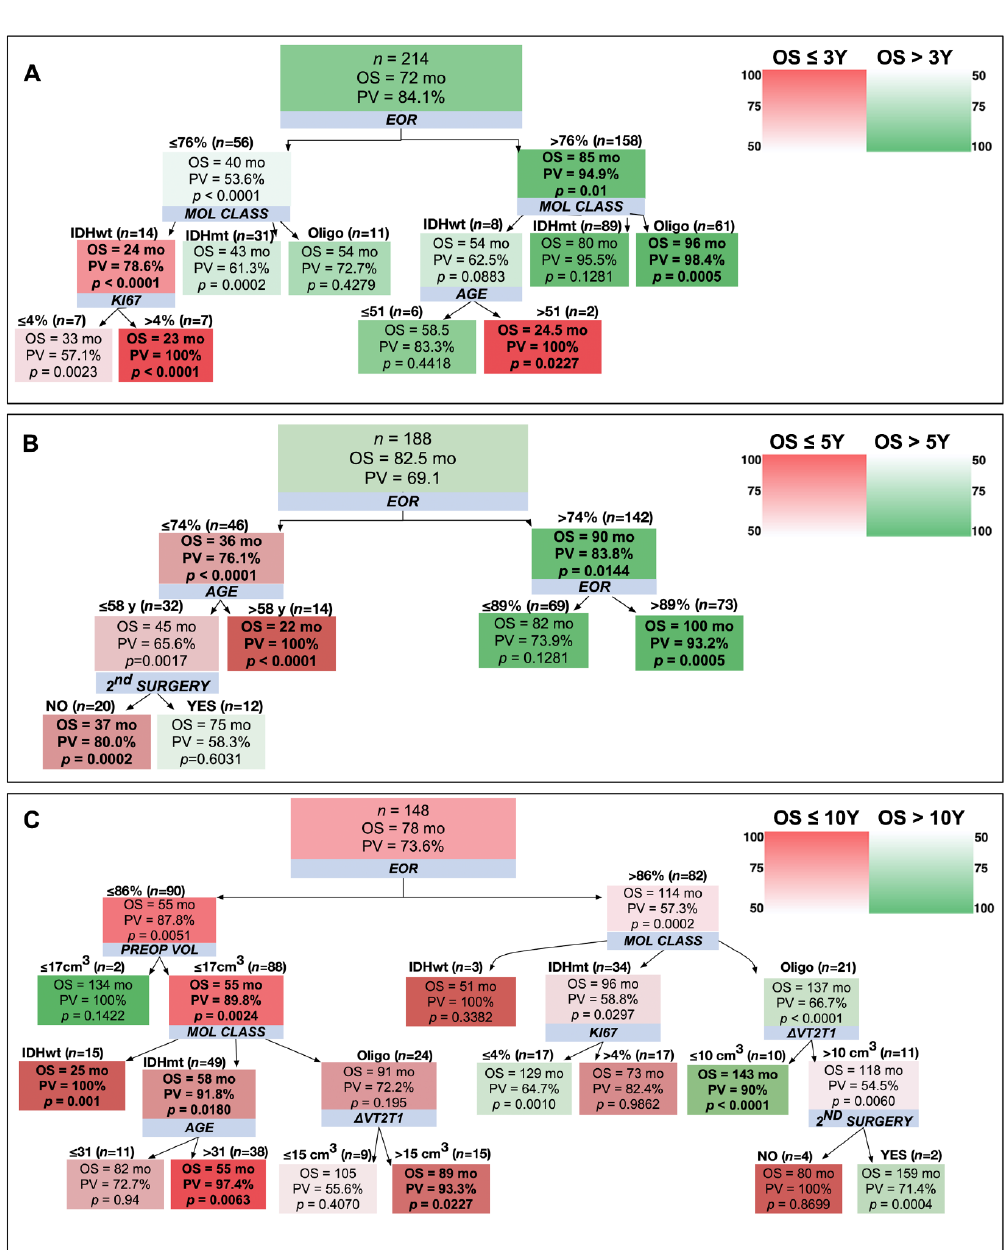
Figure 2. Decision trees (DT) to predict an OS > 3-years ( A ), 5-years ( B ), and 10-years ( C ). The shading color of the cells indicates the predictive value (PV) of an OS superior (green) or inferior (red) to 3 (A), 5 (B) or 10 years (C) (see color heat map). The top box of each DT describes the starting population (number, median OS (OS), and PV). Blue boxes show the variables stratifying the population. On top of the detected subgroups are shown the cut-off values and the number of patients satisfying them. Within the branches, boxes show the median OS of the patient subgroup, the PV, and the results of the Mann–Whitney test ( p -value) comparing the subgroup OS with that of the general population (top box). In bold are indicated the subgroups characterized by a PV >75% and a p < 0.05.